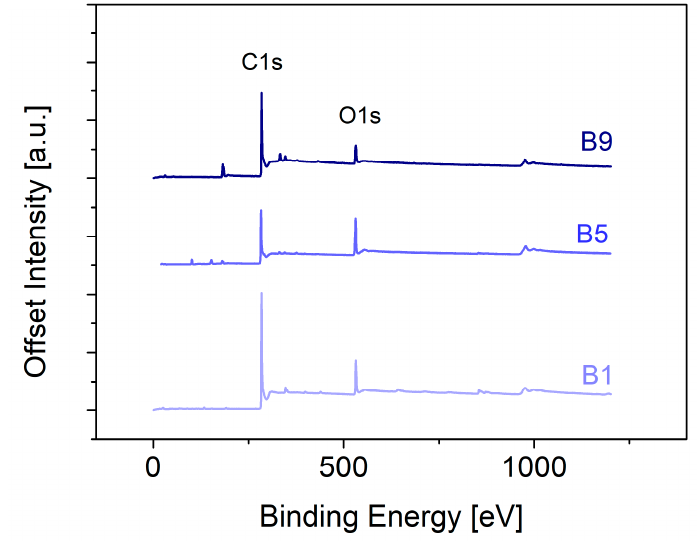
Figure 3. X-ray photoelectron spectroscopy data of the carbonized samples (B1, B5, B9).